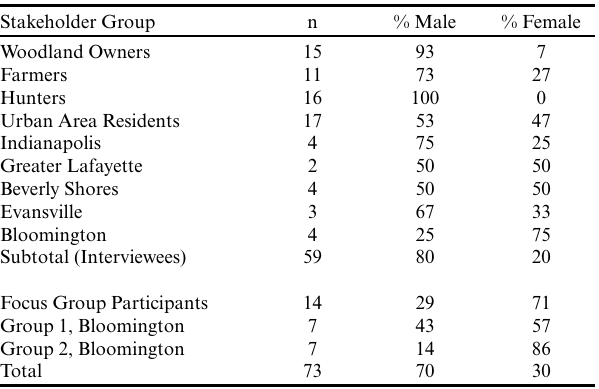
Table 1. Summary of interviewees from four deer stakeholder groups across Indiana and participants from two focus groups in Bloomington, Indiana. Semi-structured interviews were